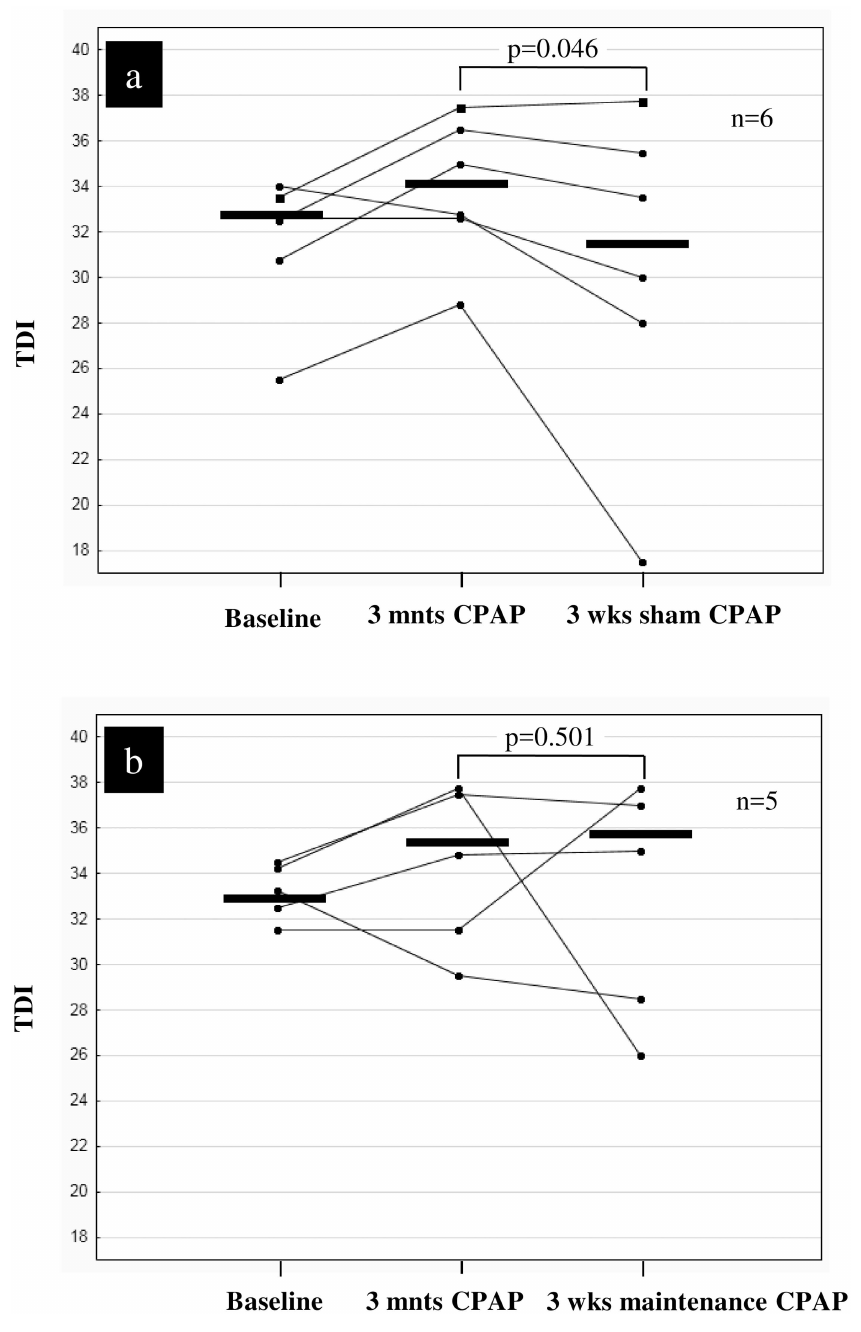
Fig 3. Olfactory performanceat baseline, three months (mnts) after start of nasal CPAP therapy and during the three weeks (wks) blinded, randomized therapy withdrawal trial in 11 adherent sleep apnea patients (Panel a: therapy withdrawal group, panel b: therapy maintenance group). TDI: threshold, discrimination and identification overall score.